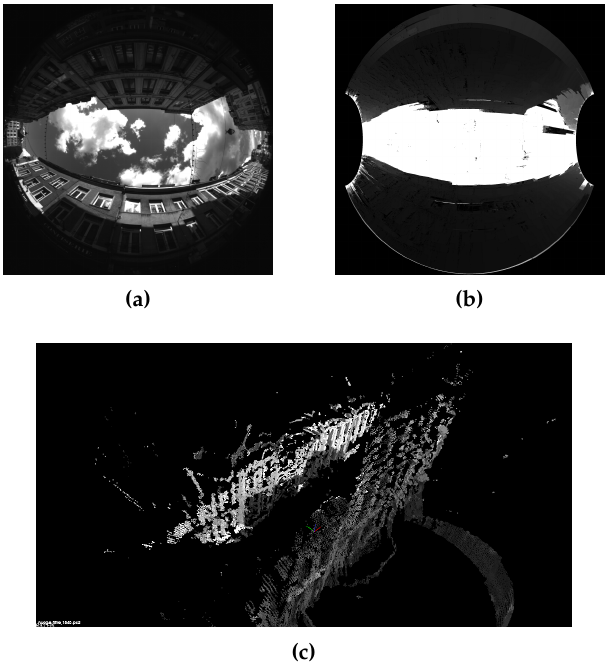
Figure 10. Distance map issued from the matching and resulting 3D model, scene Cap4/1540. ( a ) Initial rear image; ( b ) Distance map; ( c ) Filtered 3D point